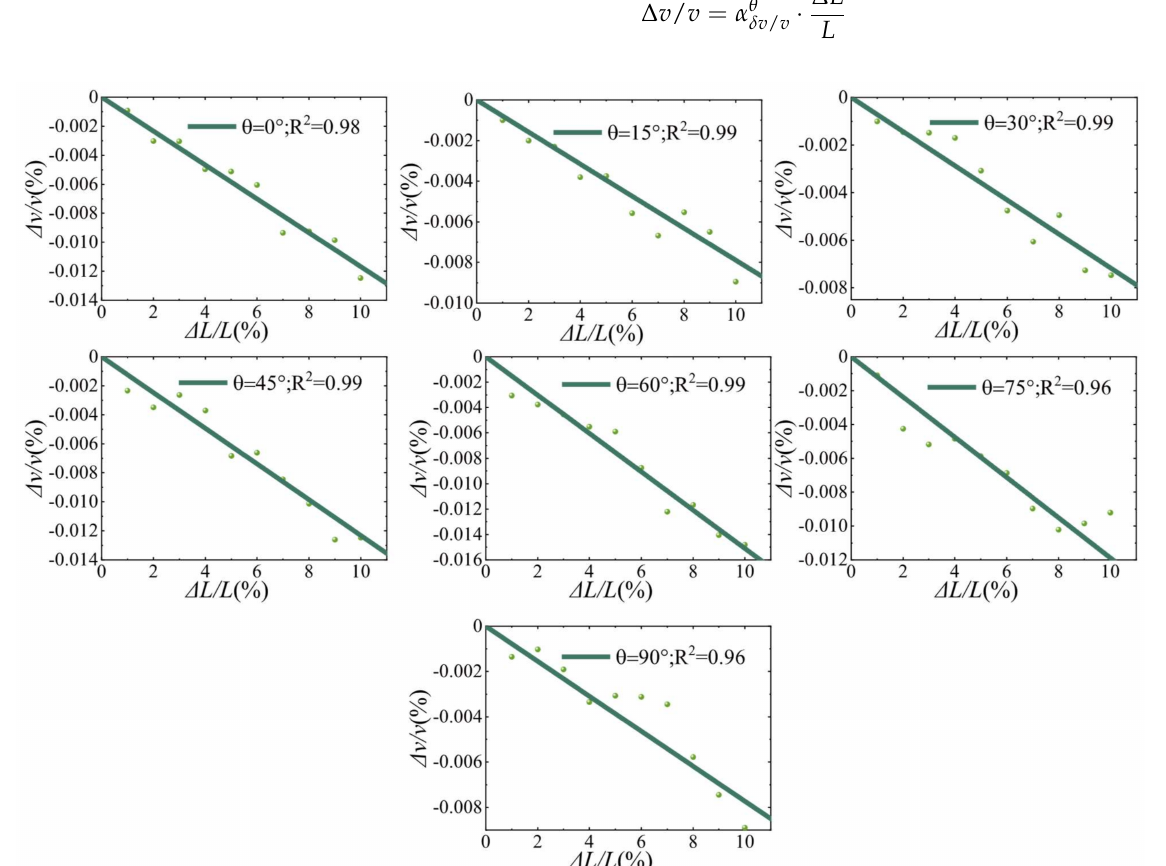
Figure 7. Correspondence between observed values of relative velocity change ( ∆ v / v ) and crack length change. For each model with an angle θ , eleven numerical models with different crack length were